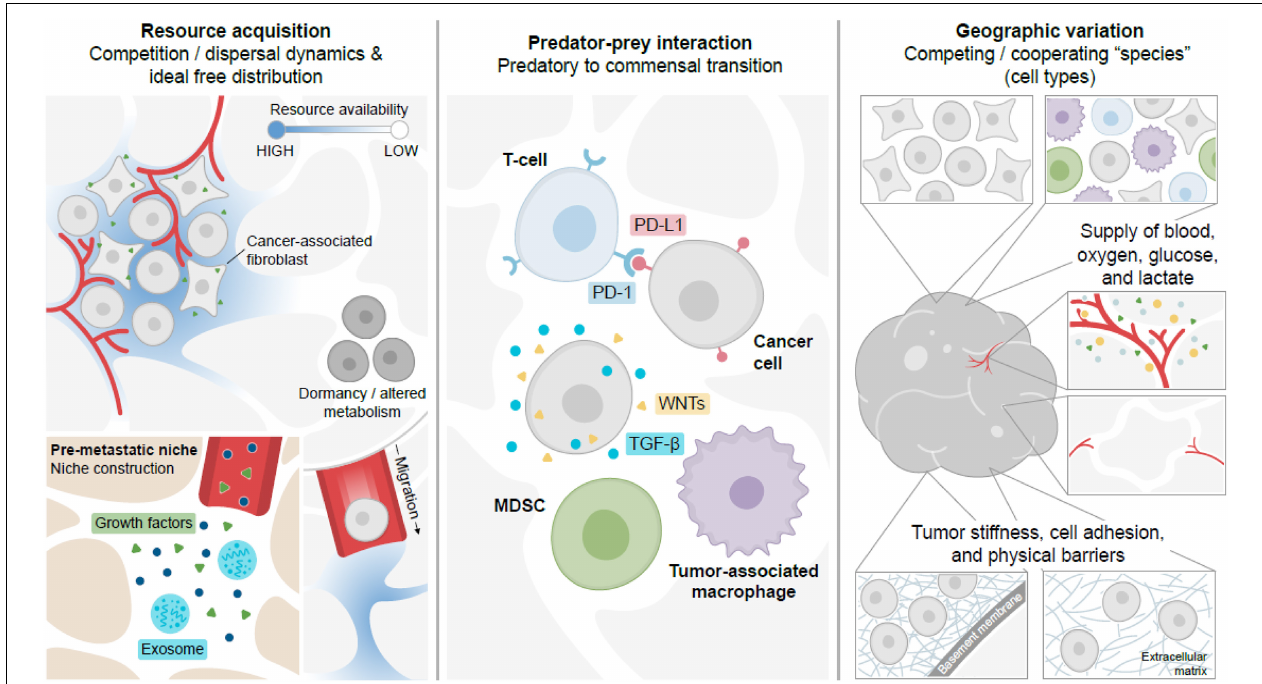
FIGURE 2 | Cancer cell survival within the dynamic ecology of the body is driven by resource acquisition, predator-prey interactions, and geography. Cancer cells within solid tumors maintain their survival through alterations in resource acquisition (cell-intrinsic and -extrinsic signals, dormancy, migration/dispersal) and niche construction. Cells must also avoid predation by the immune system through immune evasive and immune suppressive responses. These parameters are shaped by geography and resource distributions within the tumor or metastatic landscape. MDSC, myeloid-derived suppressor cell; PD-L1 is an immune evasive checkpoint molecule; WNTs and TGF- β are soluble immunomodulatory signals.